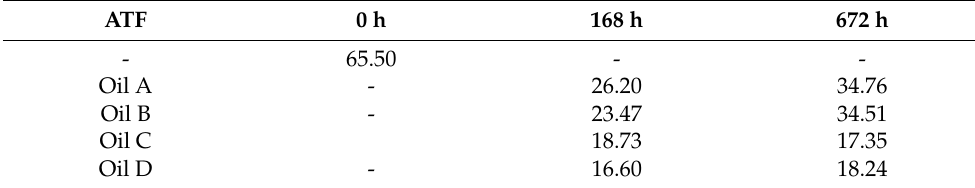
Table 6. Crystallinity percentage of the silicone samples for different aging